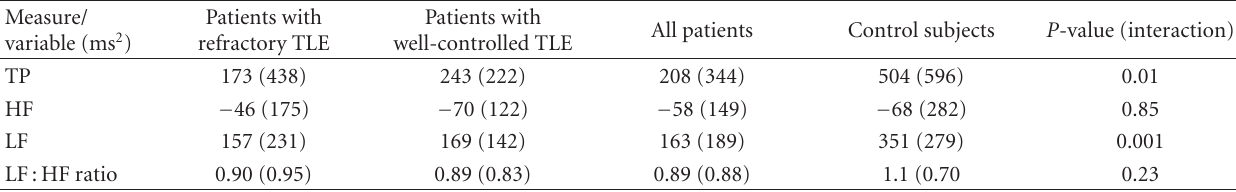
Table 4: The change in heart rate variation from supine to standing position in patients with temporal lobe epilepsy (TLE) and the control subjects. The P -value presents the di ff erences between all patients and the control subjects.